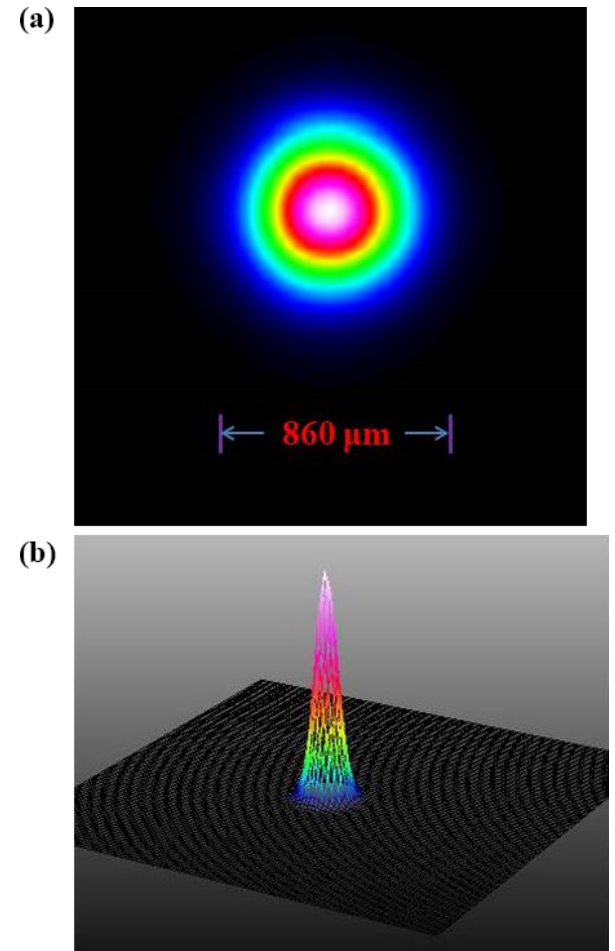
Figure 2. (a) The two-dimensional intensity distribution of the laser spot. (b) Three-dimensional laser beam profile.